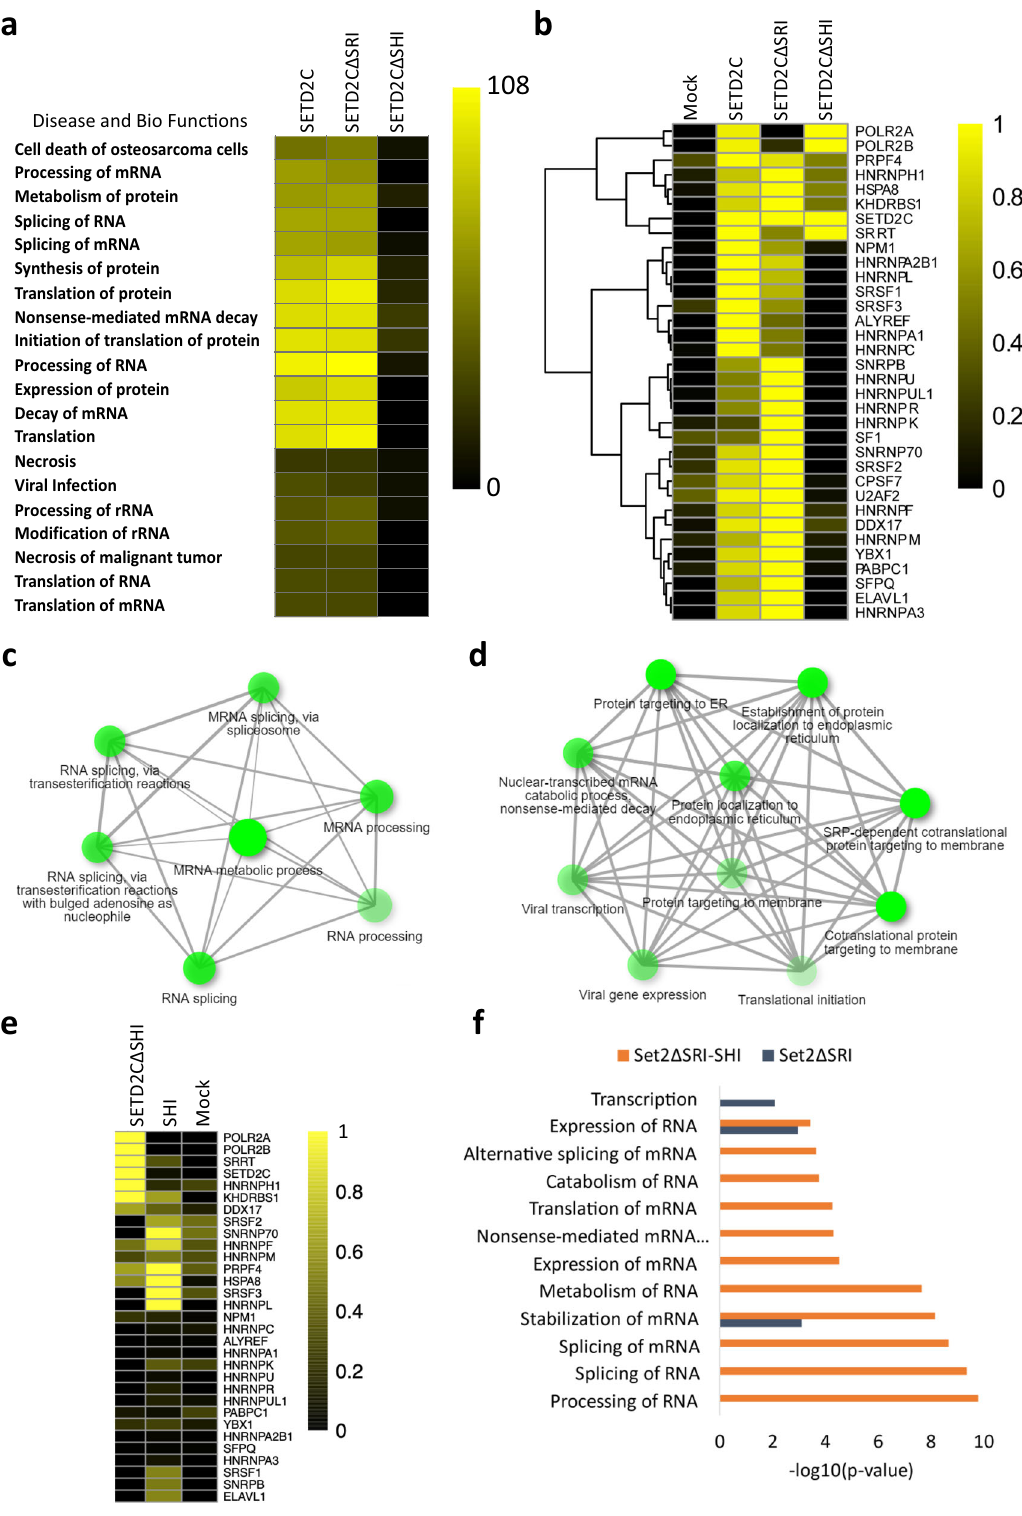
Fig. 5 SETD2 associates with splicing-related proteins through its SHI domain. a , b , e Heat maps showing the enrichment of pathways in the IPA (Ingenuity Pathway Analysis) and proteins in MudPIT analysis. c , d GO-term analysis of proteins using ShinyGO (http://bioinformatics.sdstate.edu/go/) identi fi ed by MudPIT in the af fi nity puri fi cation of SETD2 SHI and 1964 – 2113 fragments. f Chart showing the enriched pathways in IPA of ySet2 proteins. SRI Set2-Rpb1 interaction, SHI SETD2-hnRNP